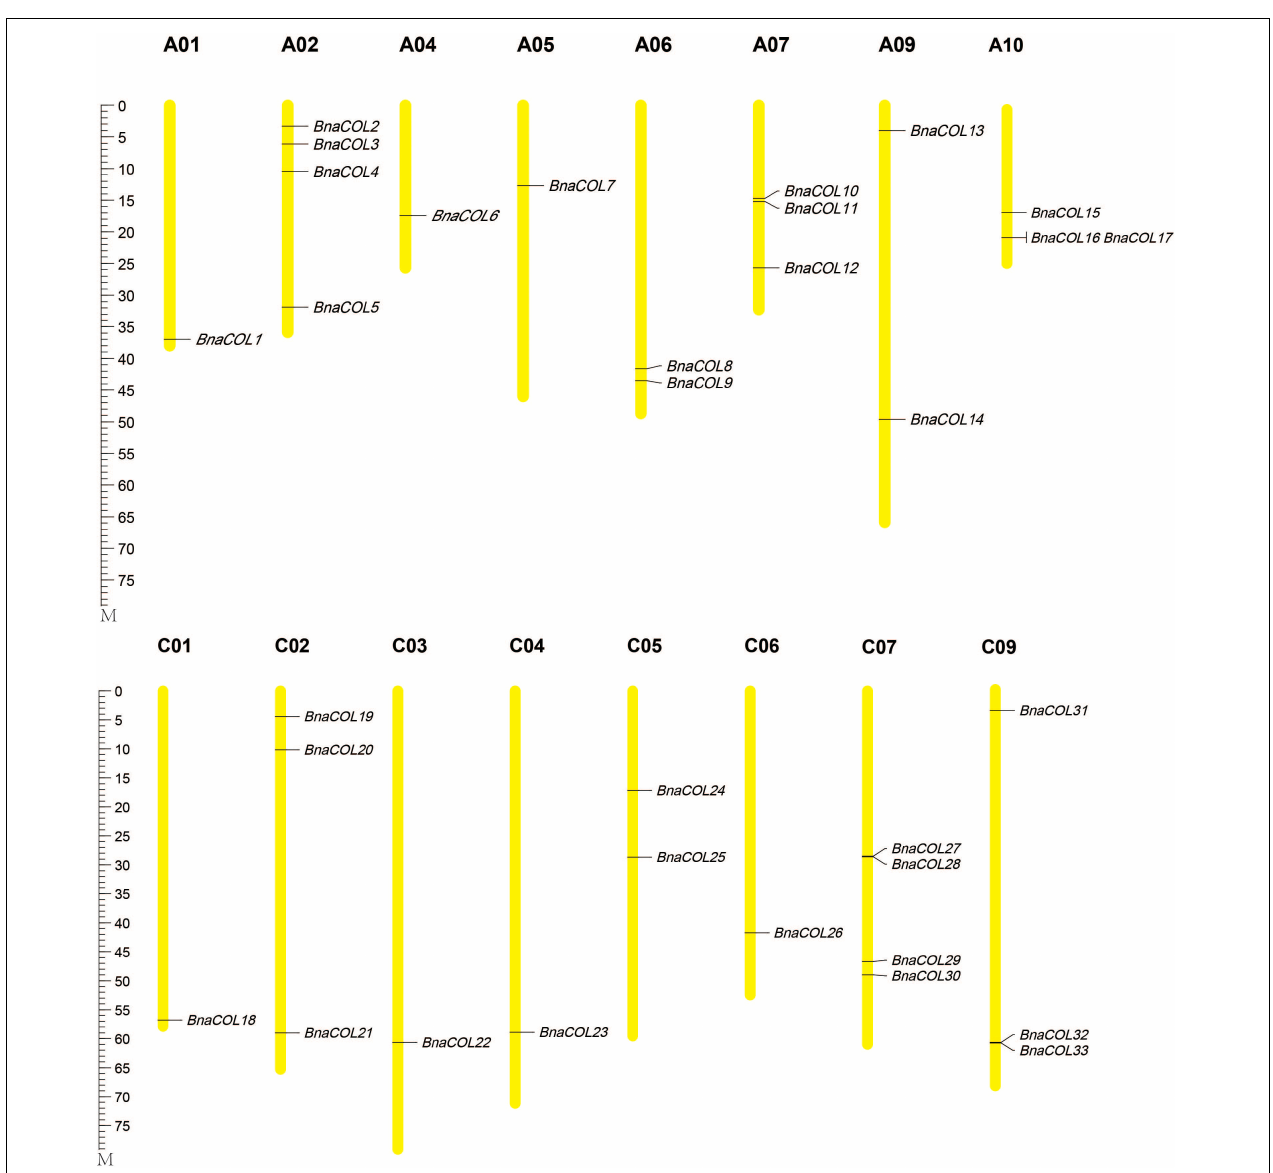
FIGURE 1 | Chromosomal localization of BnaCOL genes in B. napus. The chromosomes with different sizes are represented by the yellow vertical bars with different lengths. The locations of genes are shown from top to bottom